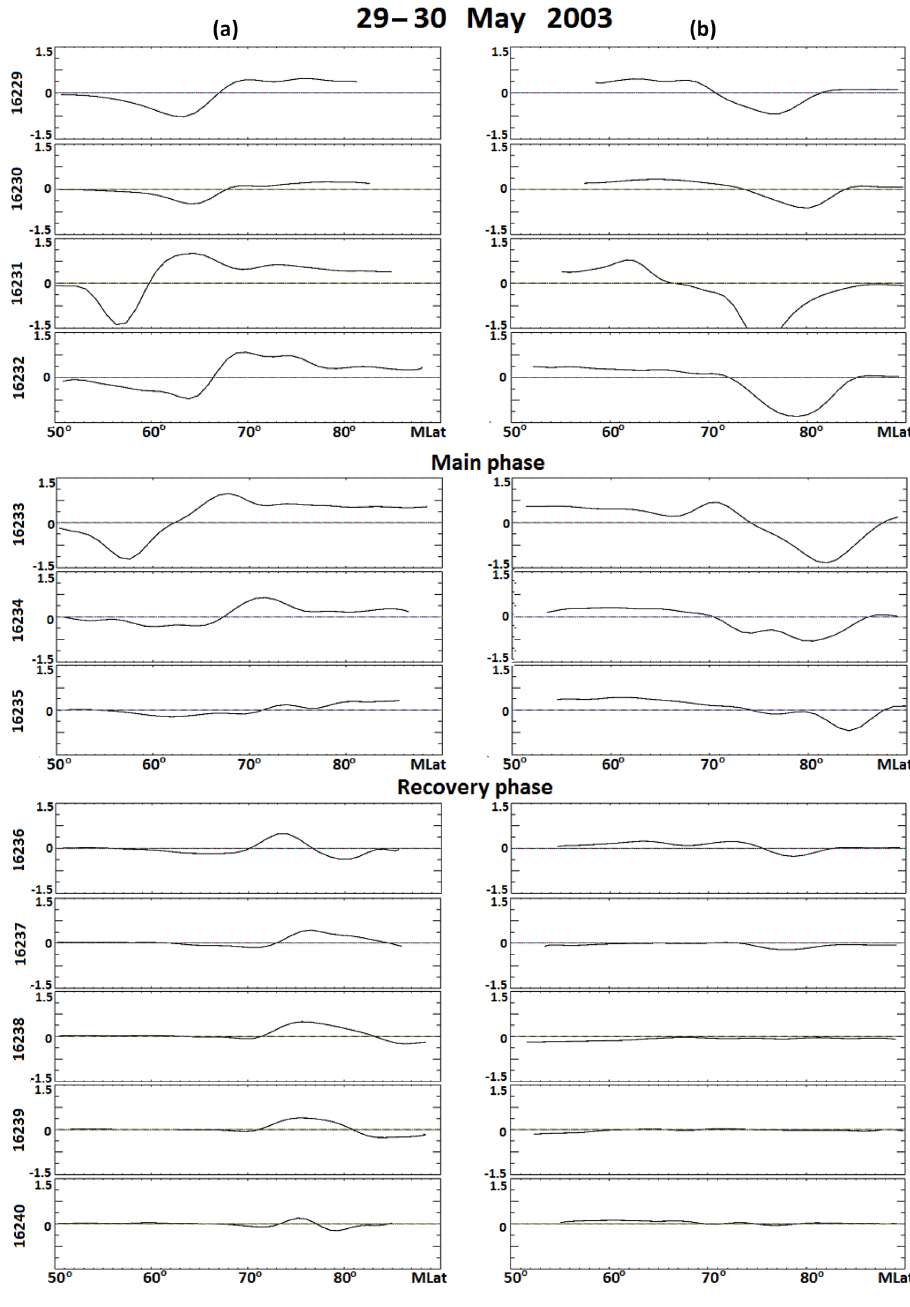
Figure 2. Direction and intensity values of the Hall current in units of ampere per meter (Am − 1 ) along the satellite orbit at the dayside ( a , 14:00–16:00MLT, corresponding to the ascending section of the orbit) and nightside sectors ( b , 02:00–04:00MLT, descending orbit section). Positive currents denote an eastward current for the descending orbit section and a westward current for the ascending section,